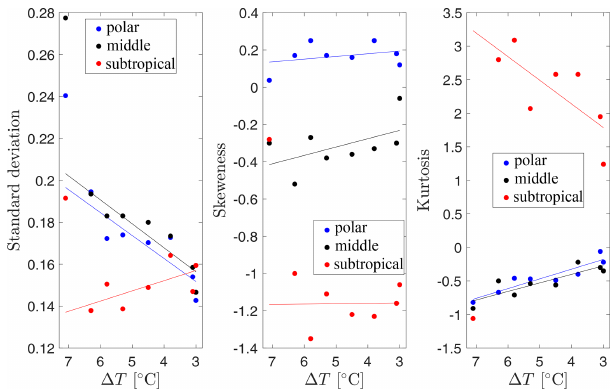
Figure 8. Standard deviation, skewness, and excess kurtosis trends for decreasing (cid:49)T for the innermost ring (blue dots), the middle ring (black dots), and the outer ring (red